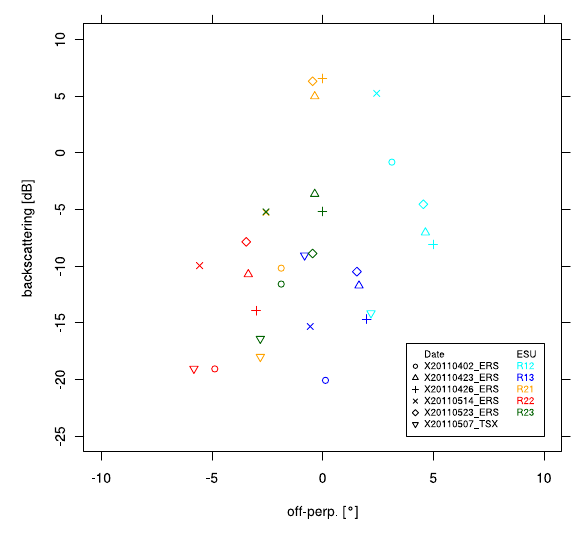
Figure 6: Backscattering [dB] versus row direction (0°= rows per- pendicular to the sensors look vector) for the roughness sample plots